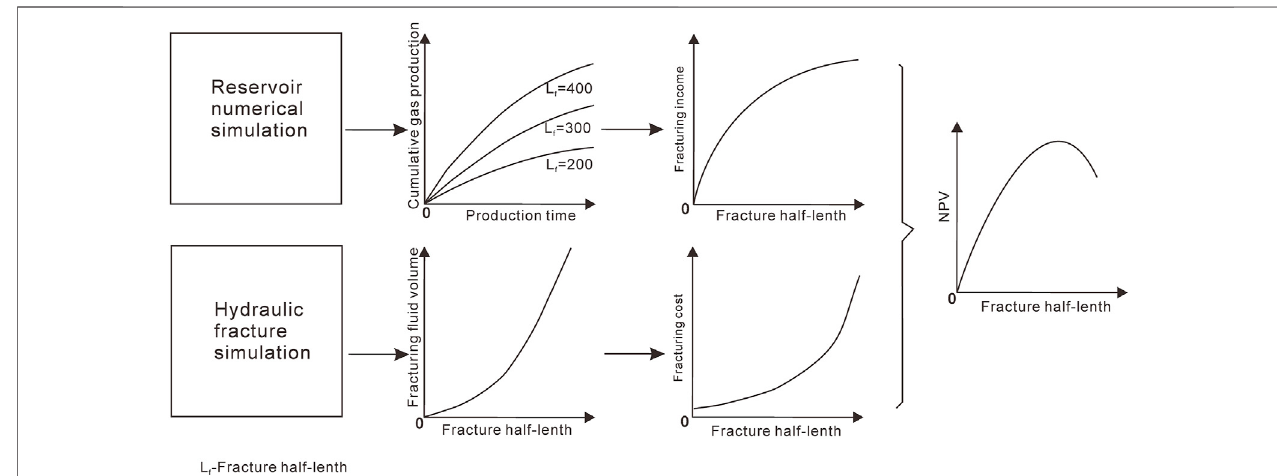
FIGURE 1 | Economic optimization diagram [modi fi ed after (Li, 2009)].